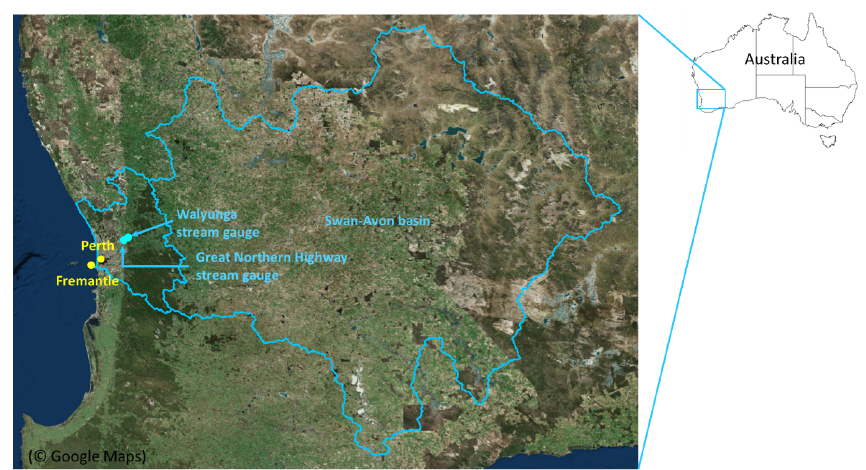
Figure 3. Locations of Perth, Fremantle, Great Northern Highway and Walyunga stream gauges, and Swan–Avon basin. The yellow dots represent the locations of major urban areas, and the blue dots represent the locations of the stream gauges. (This figure was created using © Google Maps.)